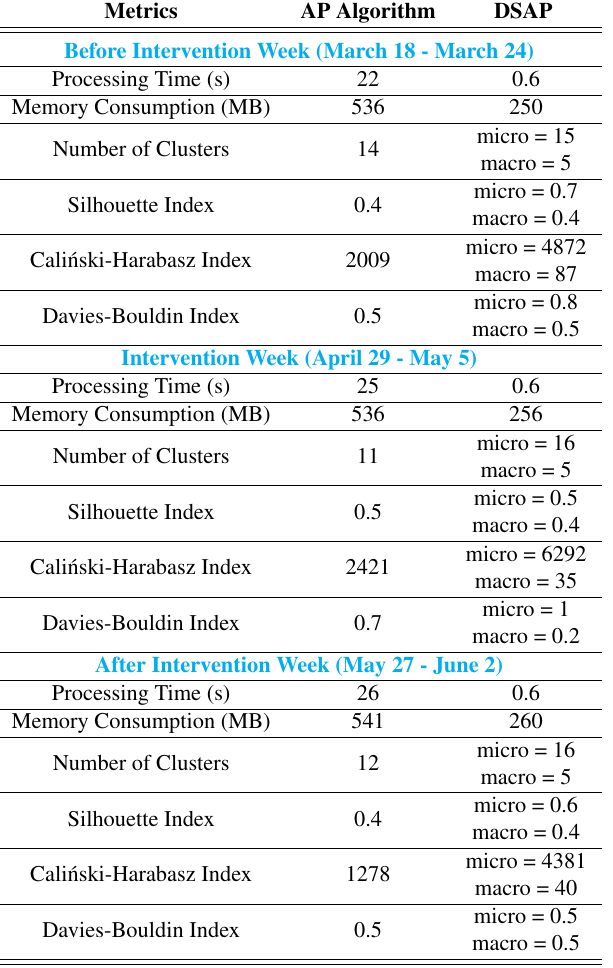
Table 2: Overall results from the performance evaluation and clustering